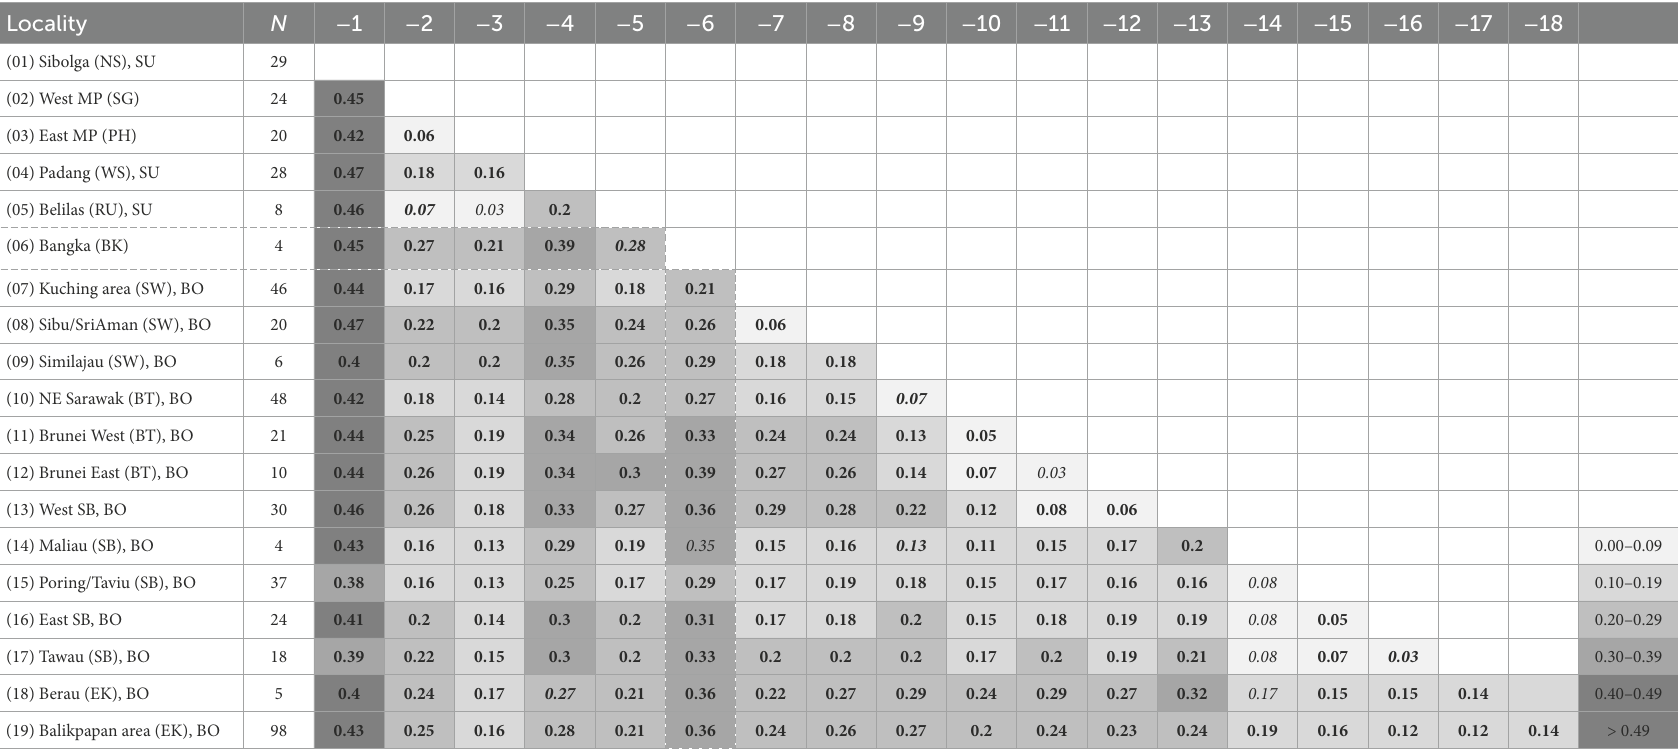
Values for Bangka/Belitung are marked with dashed lines. Significance levels are indicated by italics = p < 0.05, bold italics = p < 0.01, bold = p < 0.001. Locations indicated as abbreviations are as follows: BK, Bangka; BO, Borneo; BT, Belait (Brunei); EK, East Kalimantan; MP, Malay Peninsula; NS, North Sumatra; PH, Pahang; RU, Riau; SB, Sabah; SG, Selangor; SU, Sumatra; SW, Sarawak; WS, West